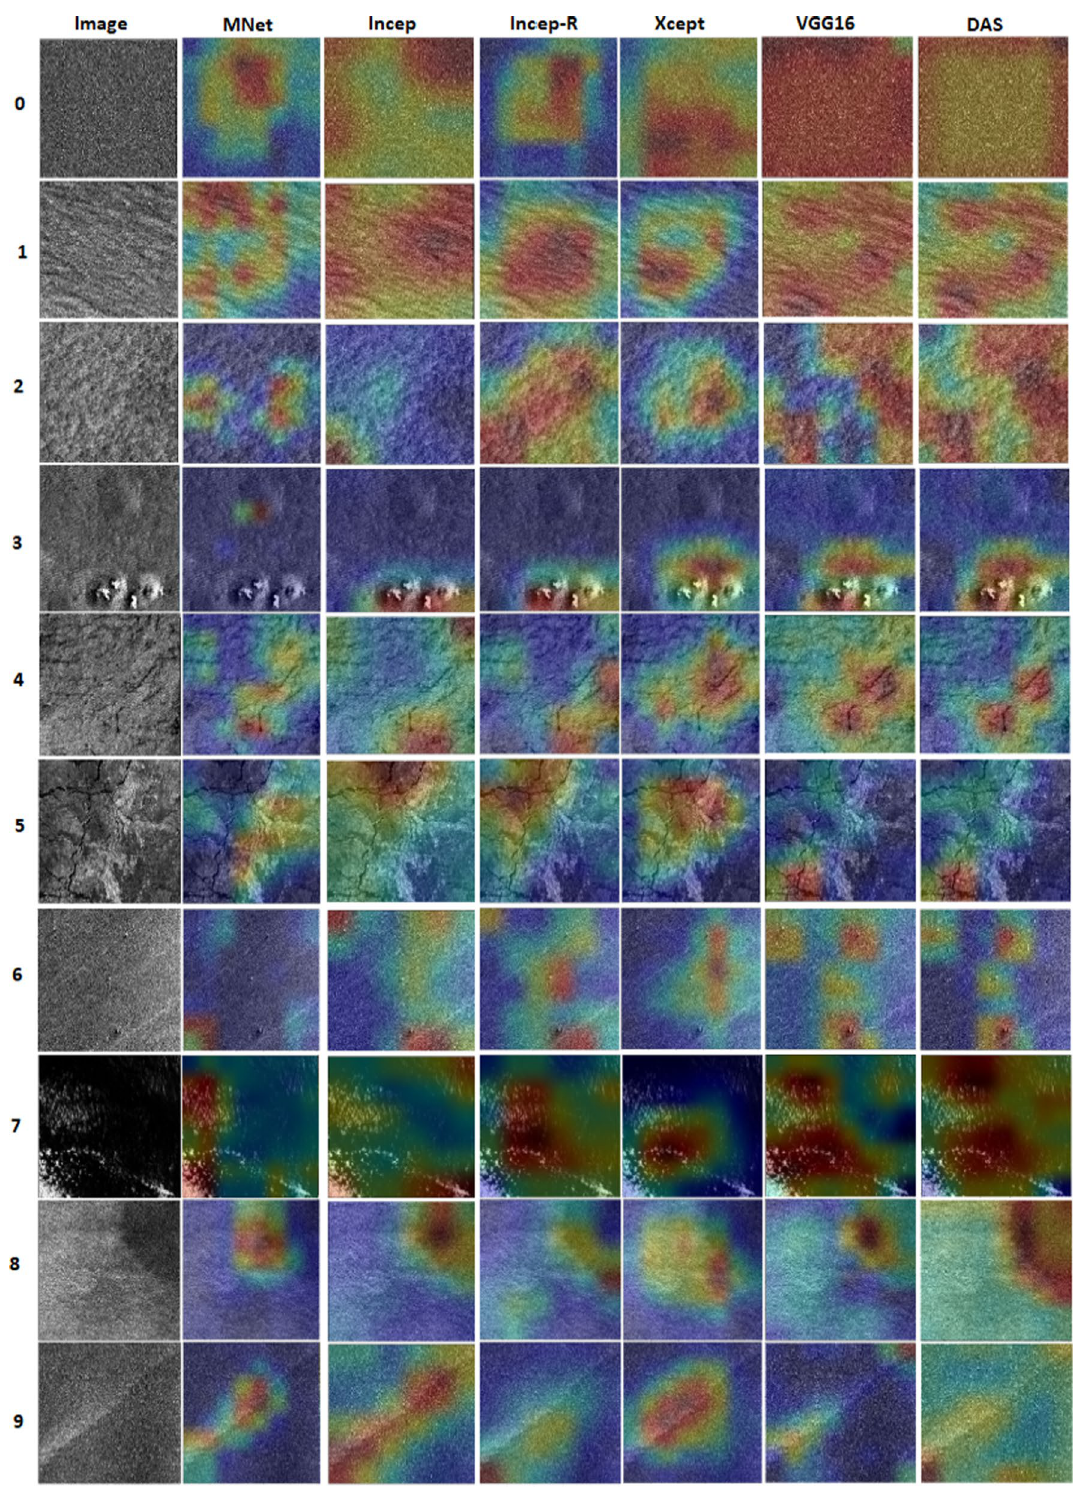
Fig. 9 Grad-CAMs produced by MobileNet V2, Inception V3, Inception-ResNet, Xception, VGG16 and Deep Attention Sampling in the TenGeoP-SARwv dataset for classes 0 (Pure Ocean Waves), 1 (Wind Streaks), 2 (Micro Convective Cells), 3 (Rain Cells), 4 (Biological Slicks), 5 (Sea Ice), 6 (Icebergs), 7 (Low Wind Area), 8 (Atmospheric Front) and 9 (Oceanic